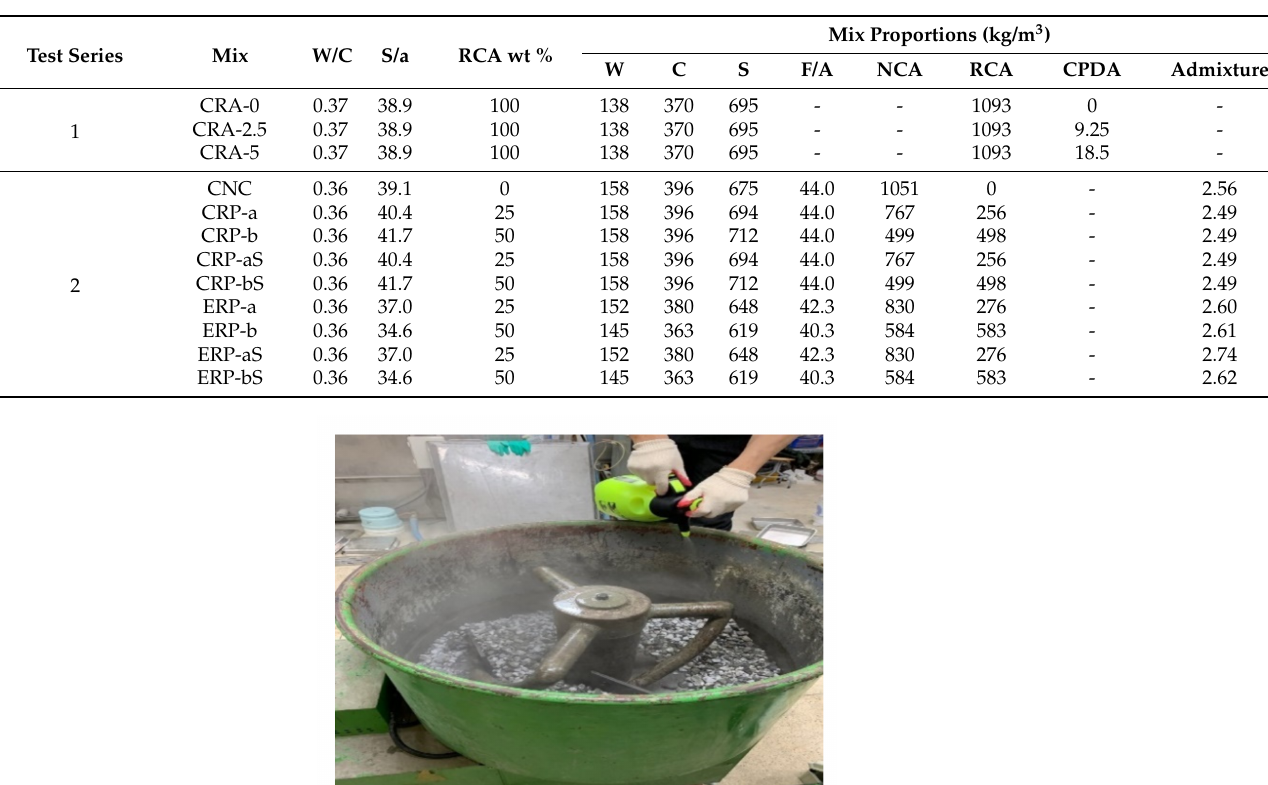
Table 2. Concrete mixture designs and material quantities.